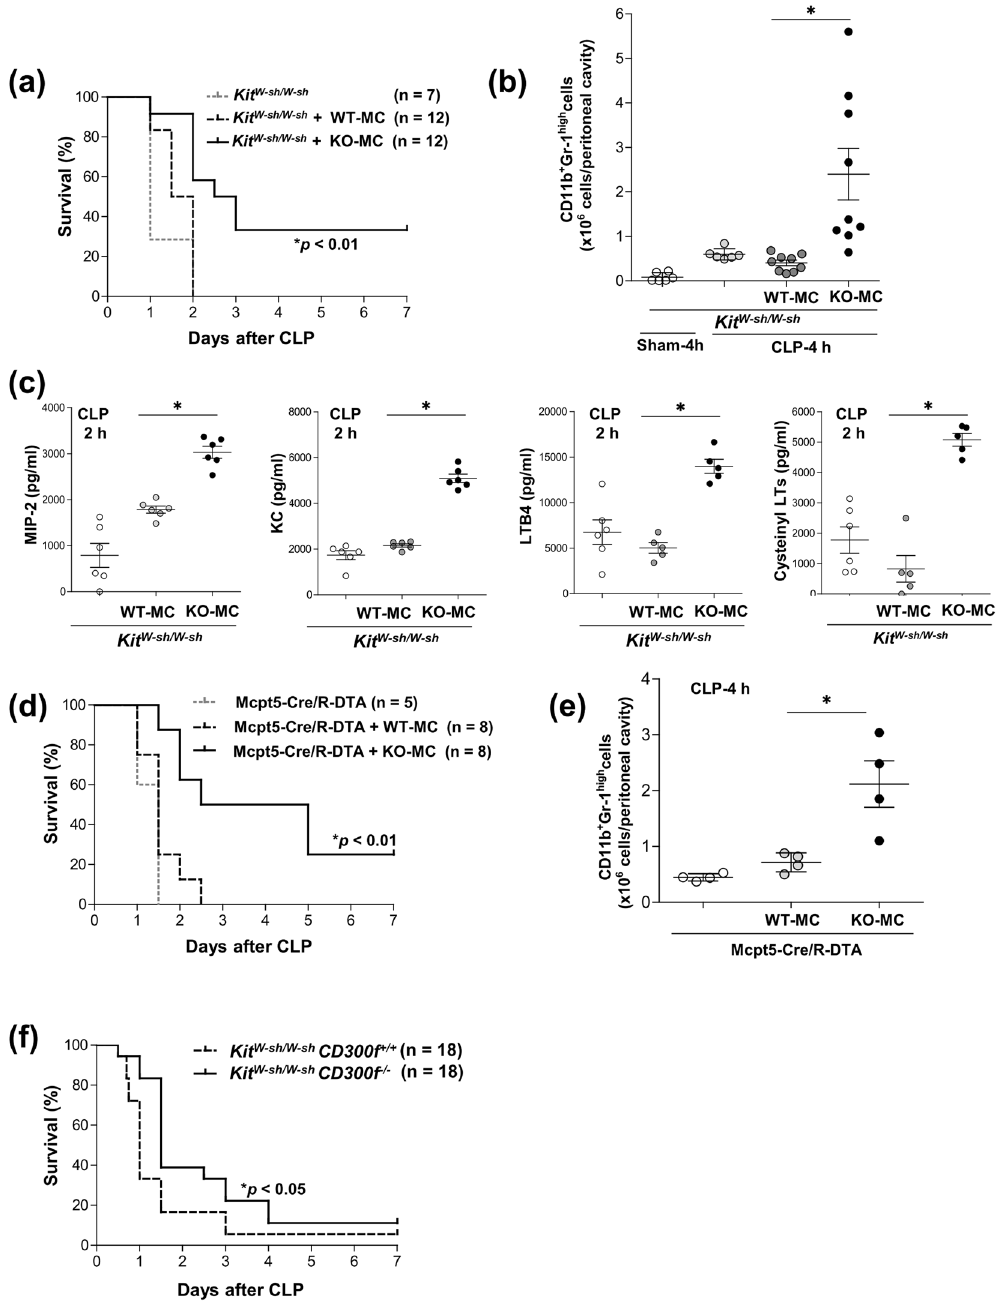
Figure 5. CD300f − / − mast cells played an important role in enhanced accumulation of neutrophils in the CLP model. ( a ) Kit W-sh/W-sh mice that had received an intraperitoneal transplant of WT or CD300f − / − BMMCs (n = 12 per group) or were injected with PBS (control, n = 7) were subjected to CLP and monitored regarding survival; * p < 0.01 compared to the mice transplanted with WT BMMCs (log-rank test). ( b,c ) Numbers of neutrophils recruited into the peritoneal cavity ( b ) and concentrations of MIP2, KC, LTB4, or cysteinyl LTs ( c ) in the indicated mice (n = 5 to 9 per group) 4 h after CLP. ( d , e ) Mcpt5-Cre/R-DTA mice that had received an intraperitoneal transplant of WT or CD300f − / − BMMCs (n = 8 per group) or were injected with PBS (control, n = 5) were subjected to CLP and monitored regarding survival. * p < 0.01 compared to the mice with a transplant of WT BMMCs (long-rank test). ( e ) Numbers of neutrophils recruited into the peritoneal cavity of the indicated mice (n = 4 per group) 4 h after CLP. ( a–e ) The data are representative of two independent experiments. ( b,c,e ) The data are expressed as mean ± SD; * p < 0.01 (Student’s t -test). ( f ) Kit W-sh/W-sh or Kit W- sh/W-sh CD300f − / − mice (total n = 18 per group) were subjected to CLP model and monitored regarding survival; * p < 0.05 (log-rank test). Data were pooled from two independent